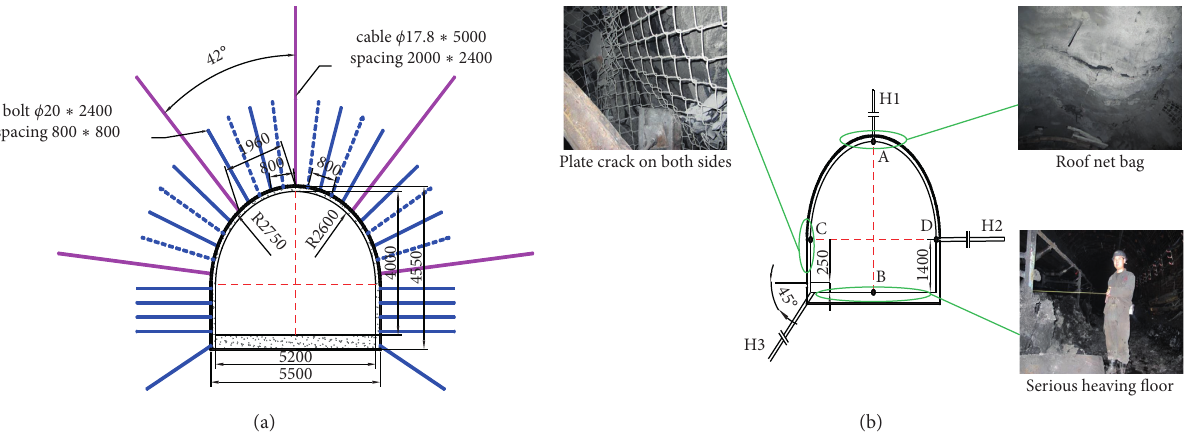
Figure 1: Damage features of auxiliary conveying roadway (unit: mm). (a) Initial support. (b) Monitoring